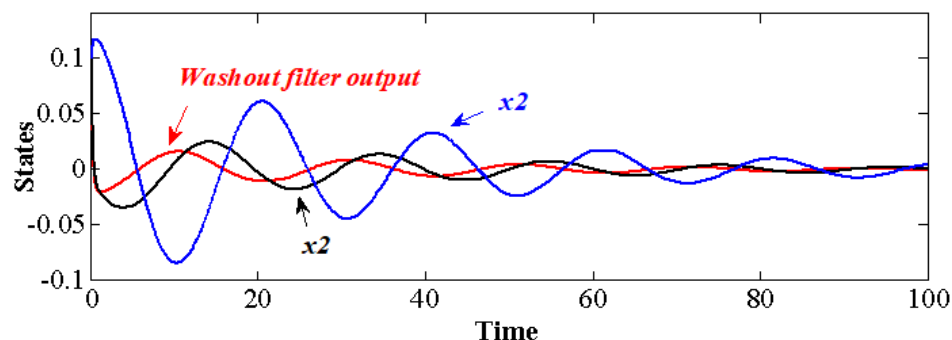
Figure 4. Time series of the closed-loop system, where the washout-filter-aided feedback parameters are d = 0.5, k =